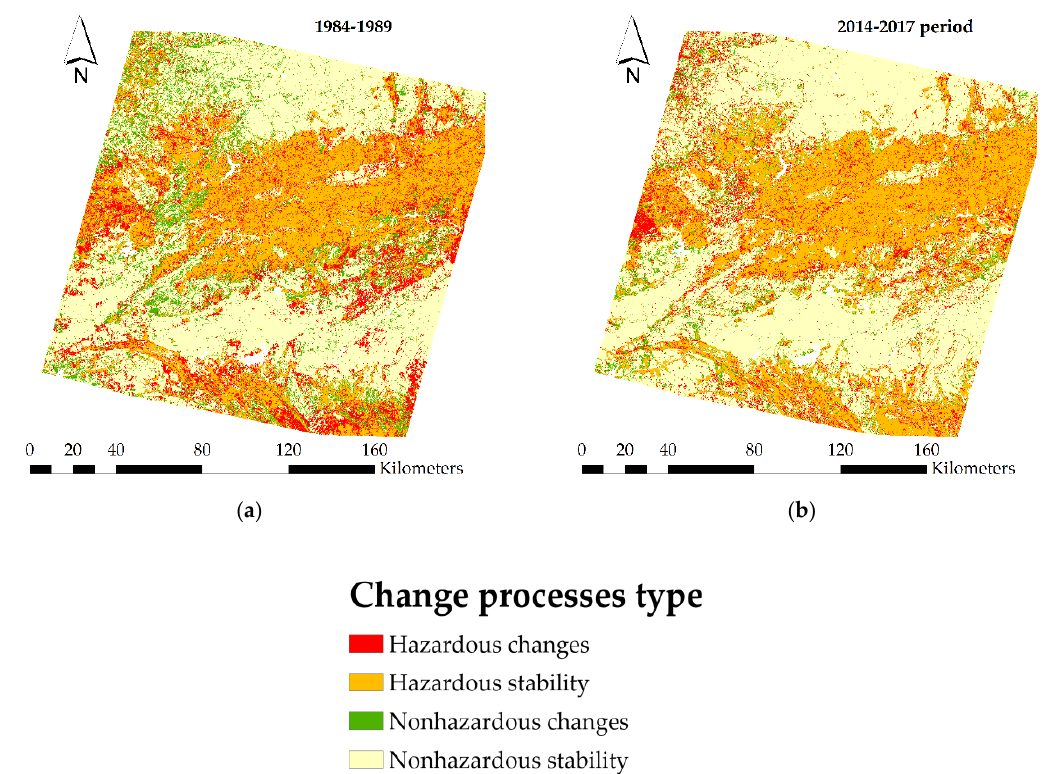
Figure 9. Spatial distribution of the change processes categorized by their hazardousness to fire for: ( a ) 1984 – 1989 period and ( b ) 2014 – 2017 period.